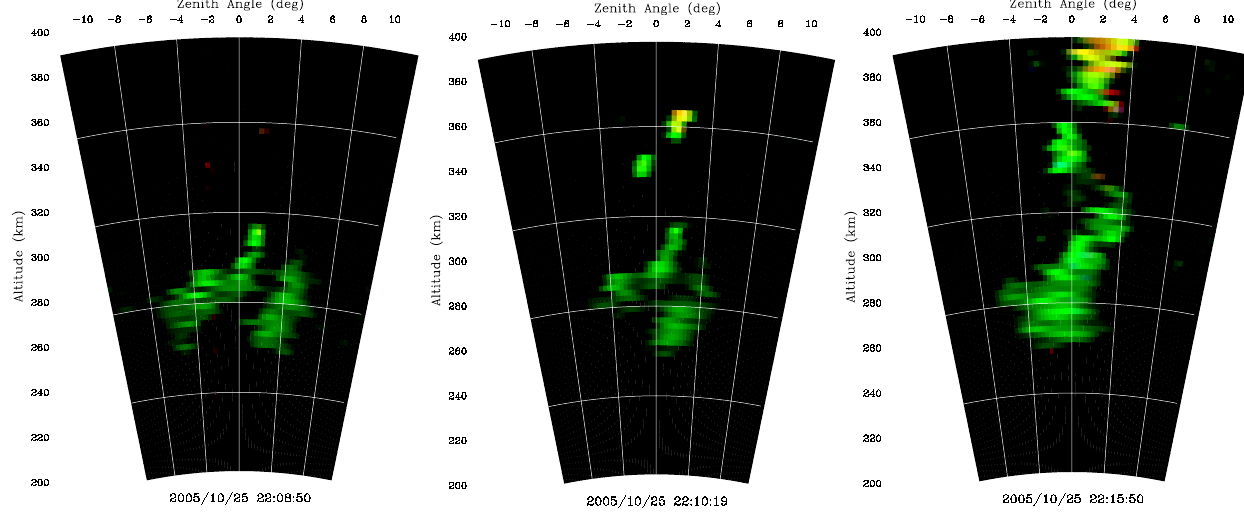
Fig. 5. Sequence of in-beam radar images showing the development of a radar